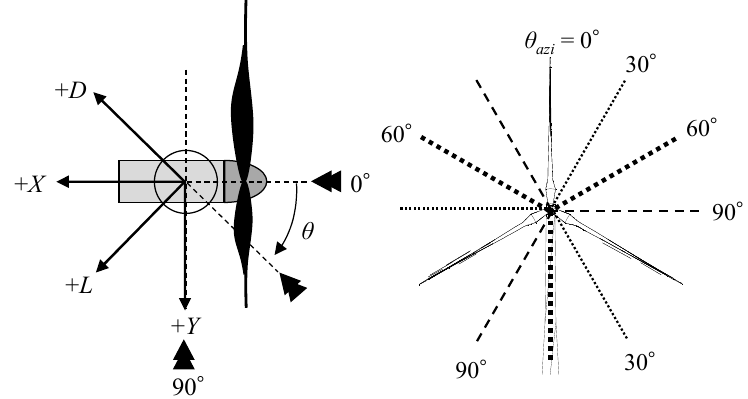
Figure 4. Definition of forces ( left ) and azimuth angle ( right ).